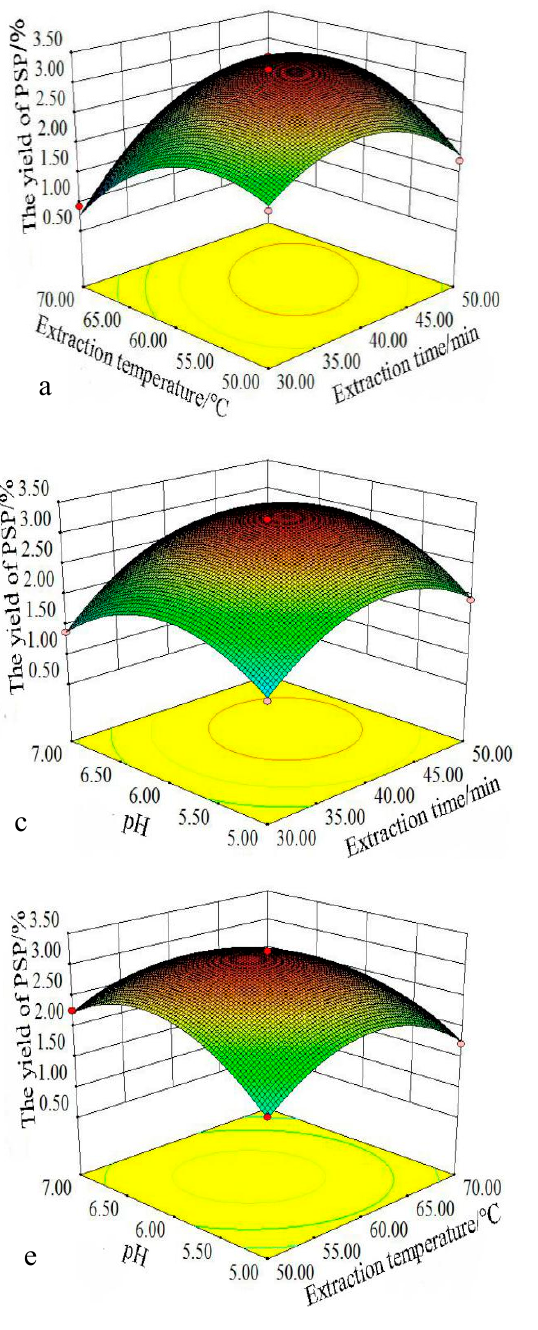
Figure 3. Response surface (3D) showing the interactions between different extraction parameters. ( a ) Extraction temperature and extraction time; ( b ) Enzyme concentration and extraction time; ( c ) Extraction time and pH; ( d ) Enzyme concentration and extraction temperature; ( e ) Extraction temperature and pH; ( f ) Enzyme concentration and pH.